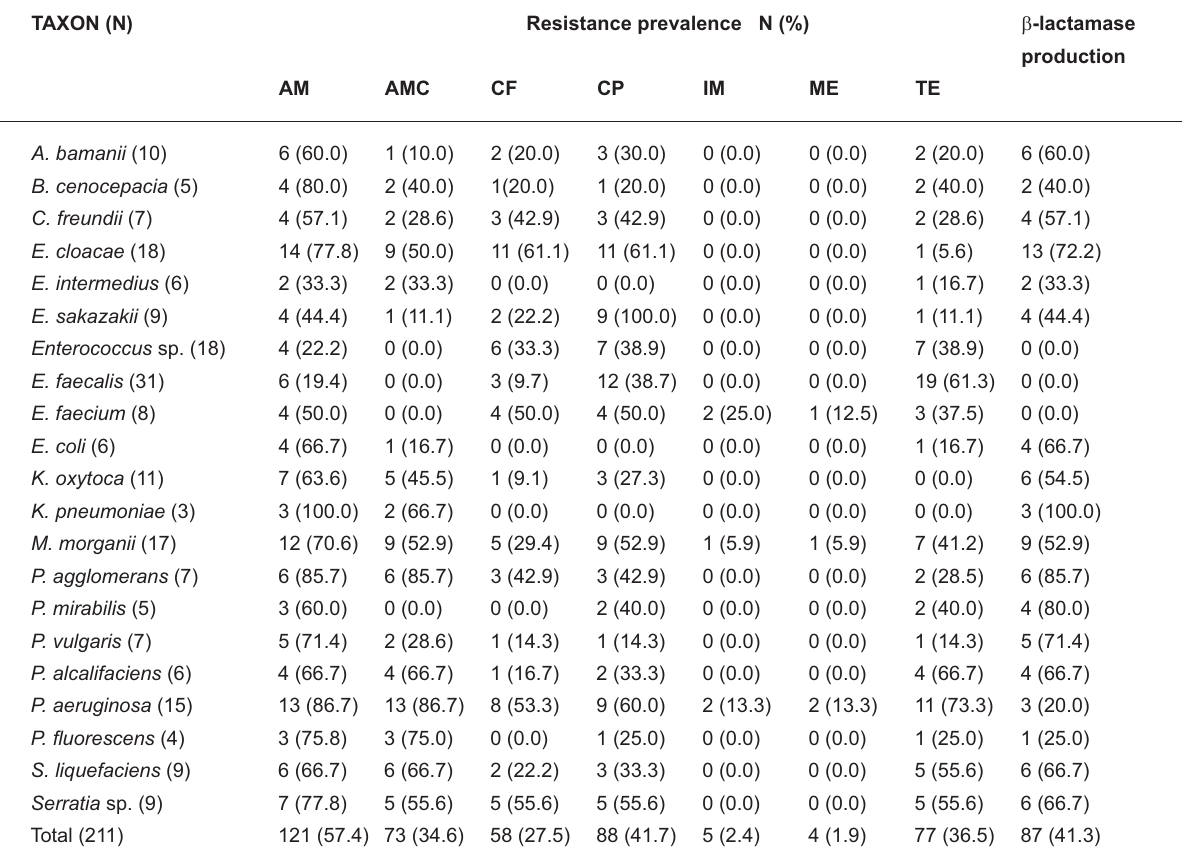
AM= ampicillin; AMC= amoxicillin/clavulanic acid; CF= cefoxitin; CP= cephalotin; IM= imipenem; ME= meropenem; TE=